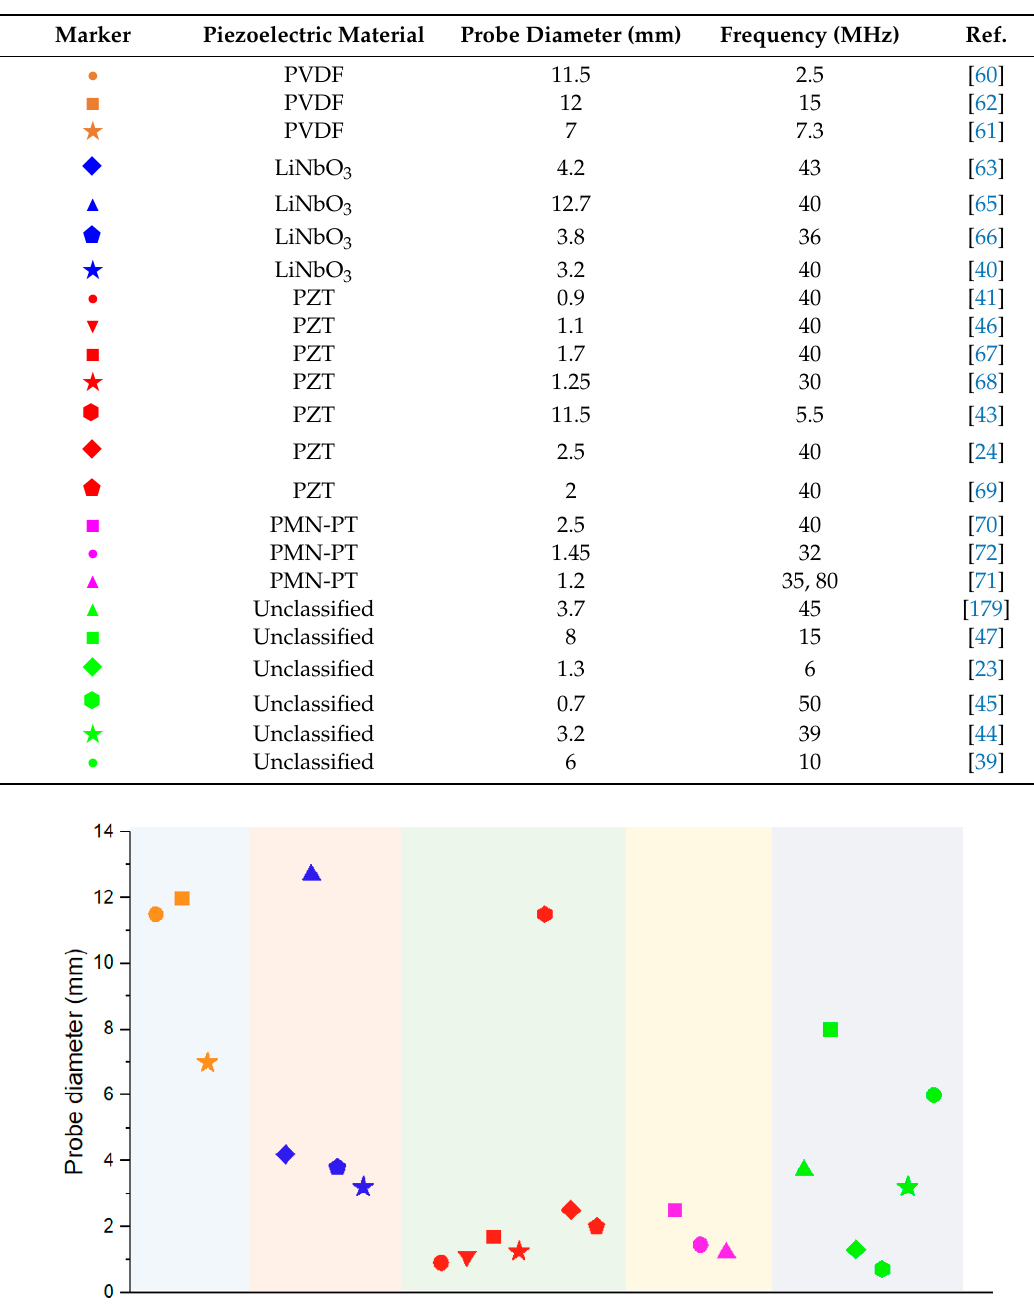
Table 7. Summary of photoacoustic endoscopes based on TEM pMUTs.